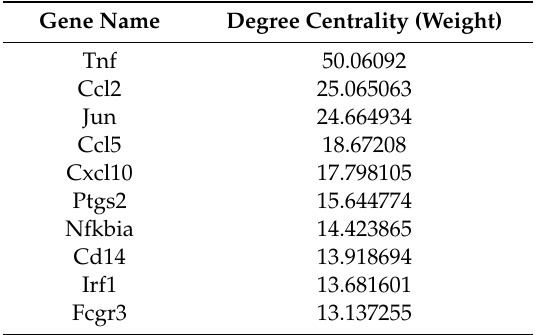
Table 2. Degree centrality analysis of antiviral response gene (group 4) revealing the top 10 candidates.